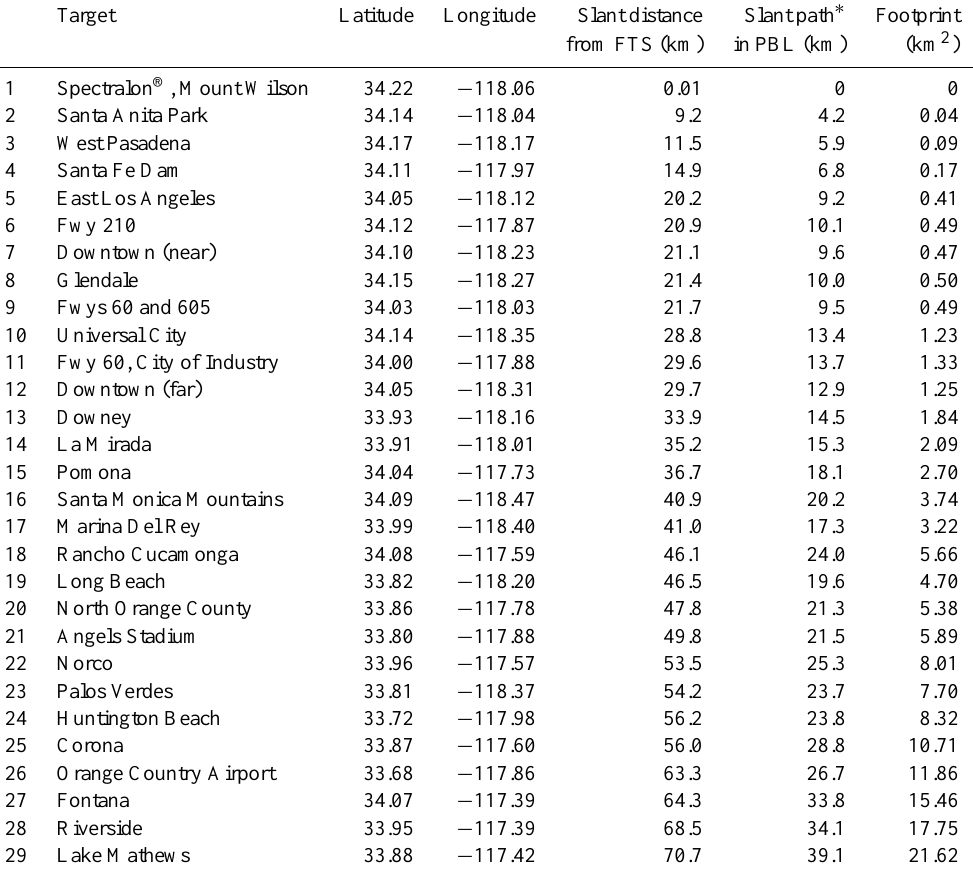
Table 1. List of the 29 reflection points on Mount Wilson and in the Los Angeles megacity.